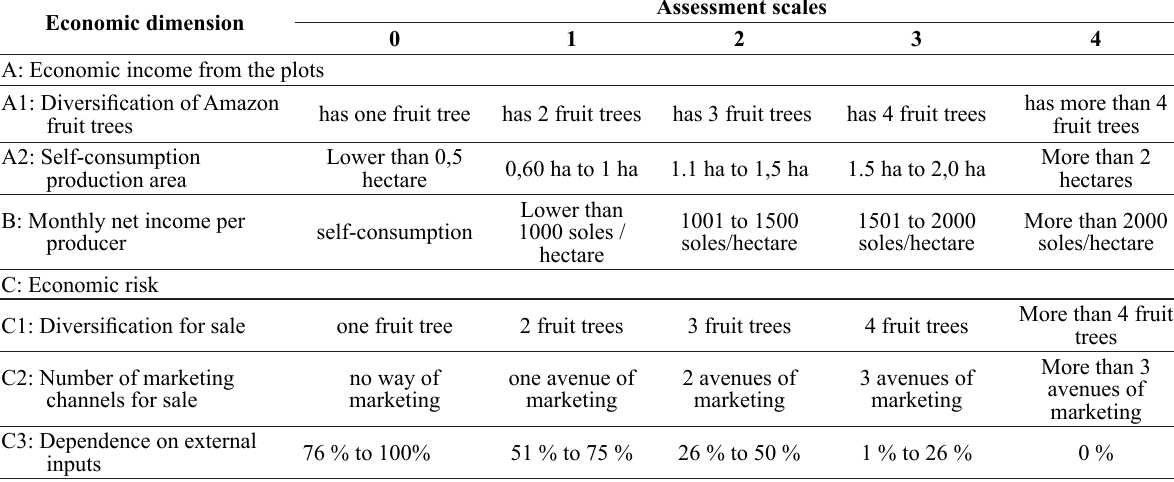
Table 1: Sub-indicators, variables and valuation scales to assess the economic sustainability of plots producing Amazonian fruit trees on the Iquitos - Nauta highway Economic